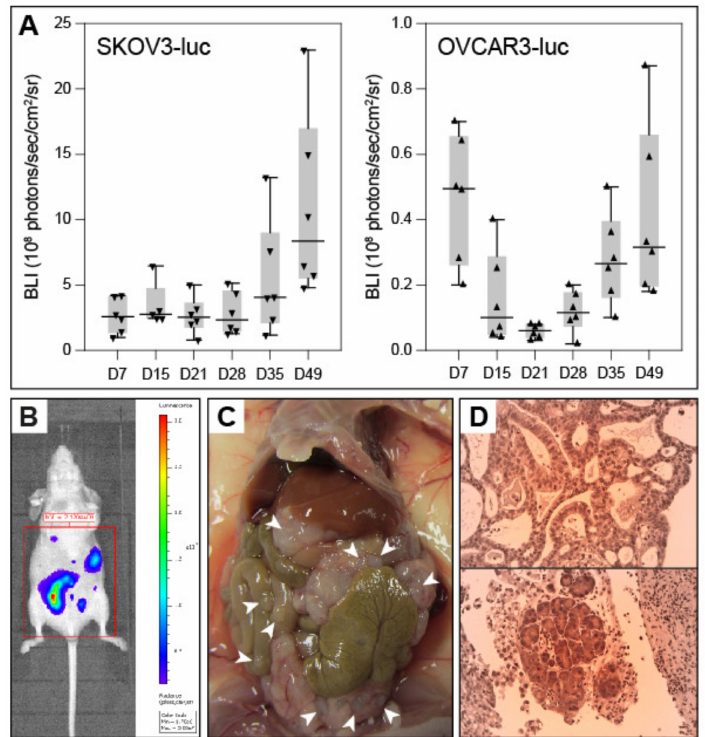
Figure 1. Mouse ovarian peritoneal metastasis model. ( A ) Tumor growth (SKOV3-luc, left panel; OVCAR3-luc, right panel; n = 6 mice per cell line) measured by bioluminescence imaging (BLI) over 7 weeks. Box plots: horizontal line, median; box, 25 / 75-th percentile; whiskers, 10 / 90-th percentile; triangles, individual data points. ( B ) Representative BLI quantification (SKOV3-luc). ( C ) Representative necroscopy showing numerous tumor nodules (arrowheads). ( D ) Representative histopathology images (HES staining) showing massive peritoneal infiltration by a solid and glandular tumor mass containing some focal necrosis (upper panel). Focally, a micropapillary pattern is also observed (lower panel). Tumor cells display a severe anisokaryosis and numerous abnormal mitotic figures, and in some areas, clear cells are observed (both panels). Magnification: ×